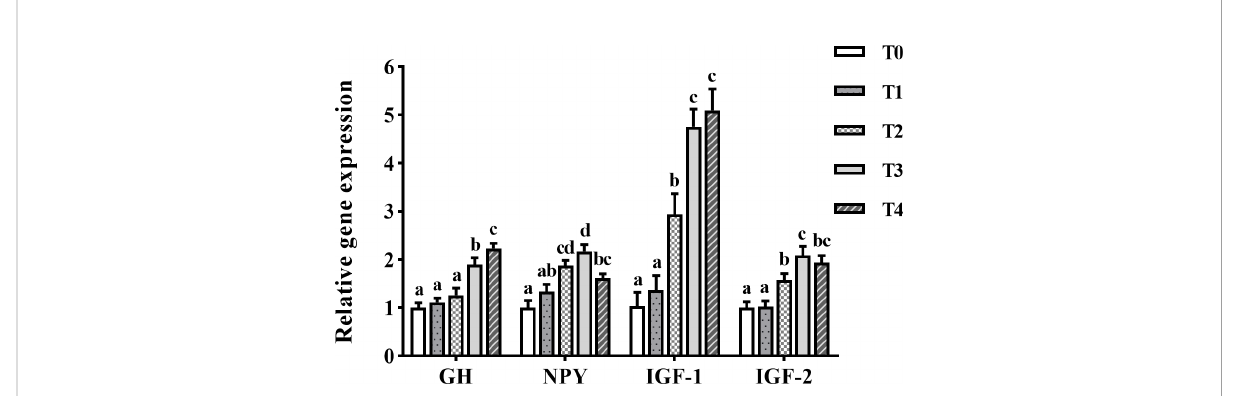
FIGURE 3 The expression pro fi les of growth-related genes in the liver and the brain of T. ovatus fed diets with different dose taurine supplementation after 8 weeks. Mean values (n = 9) within values in the picture above with different superscripts are signi fi cantly different ( P <